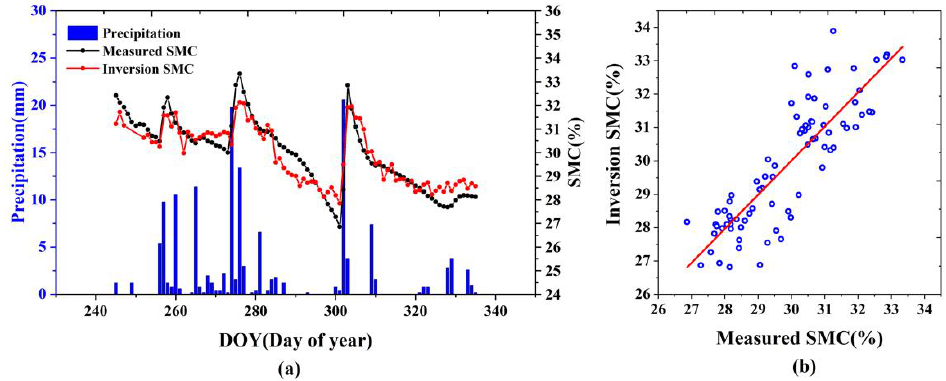
Figure 12. ( a ) Comparison of the results after integration with the measured soil moisture. ( b ) Correlation analysis of the integration results with the measured soil moisture.